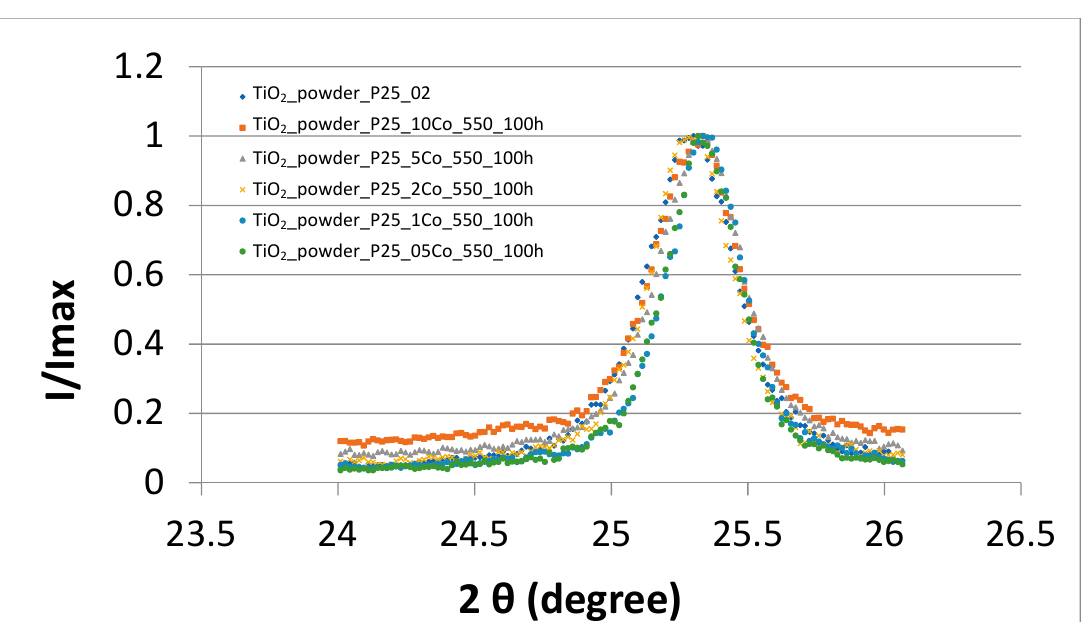
Figure 3. XRD peak ((101)—anatase) patterns of TiO 2 Degussa P25 powders doped with Co.